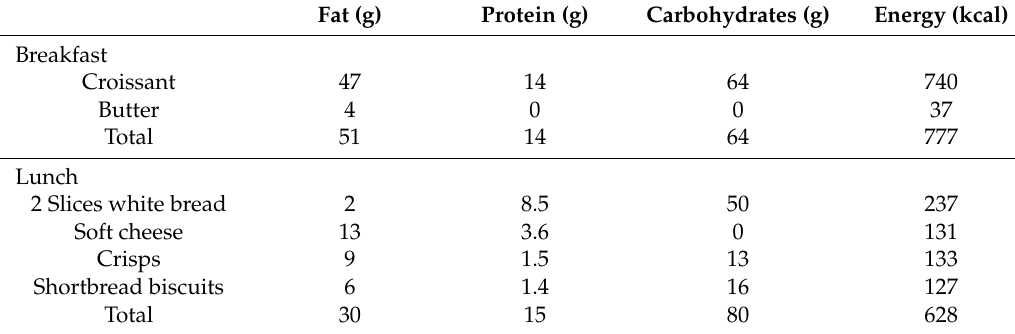
Table 1. Macronutrient composition of breakfast and lunch consumed with the study